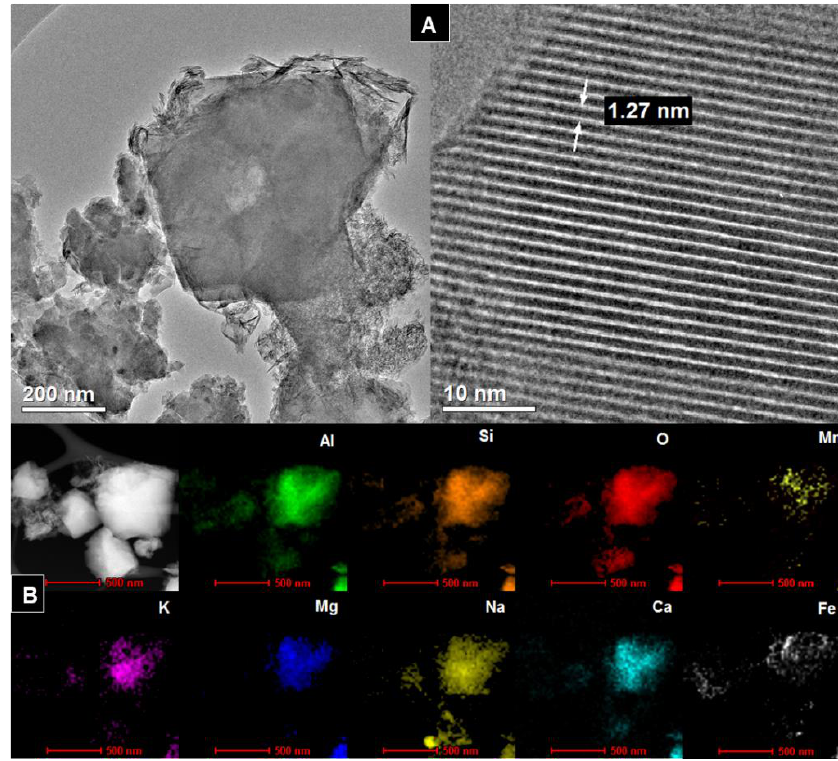
Figure 5. ( A ) HR/TEM images and ( B ) STEM-EDS analysis of Na-X-TS sample.